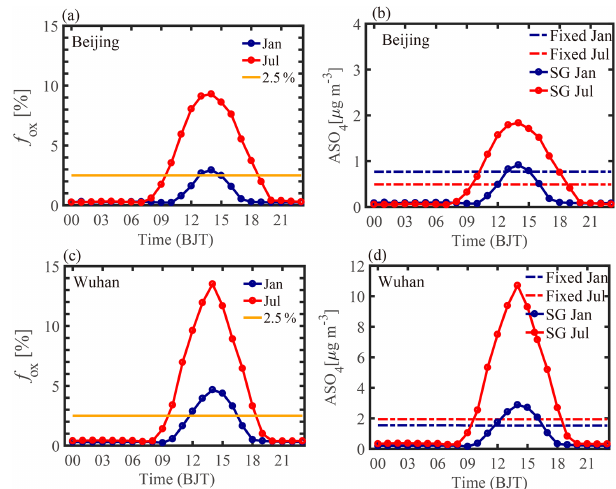
Figure 4. Monthly averaged diurnal variation in the oxidation rate ( f ox , a, c ) and mass concentration (µgm − 3 ) of sub-grid sul- fate (b, d) in January (blue line) and July (red line) from the IAP- AACM. The orange line represents constant f ox of 2.5%. The solid line and dash-dotted line represent simulation with the sub-grid scheme (SG) and constant f ox of 2.5% (F2.5), respectively. The top row and bottom row are for Beijing and Wuhan,